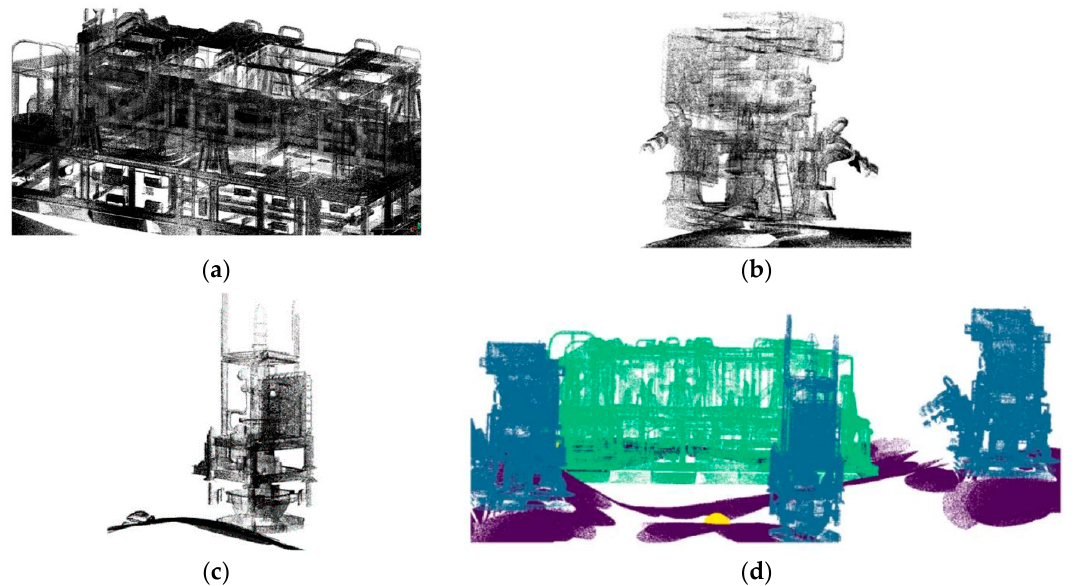
Figure 13. ( a ) Manifold point cloud; ( b , c ) Wet Christmas Tree point cloud; ( d ) The merged point clouds with identification property highlighted [29].